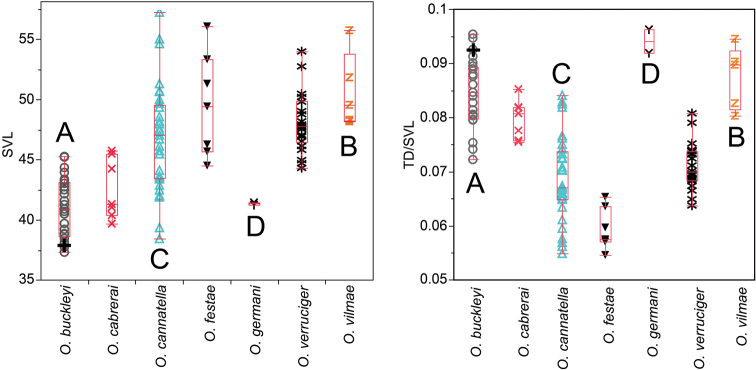
Boxplots for snout-vent length (SVL; left) and the ratio tympanum diameter/snout-vent length (TD/SVL; right). The line in the middle of the box represents the median, and the lower and upper ends of the box are the 25% and 75% quartiles respectively. Each individual is shown with a symbol; the cross in Osteocephalus buckleyi represents the lectotype. Letters correspond to those of clades on Figure 1.